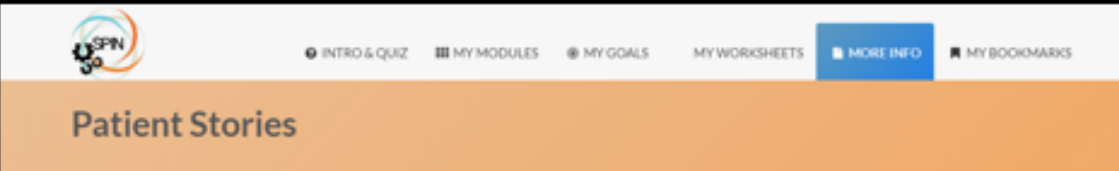
Figure 8. Patient stories